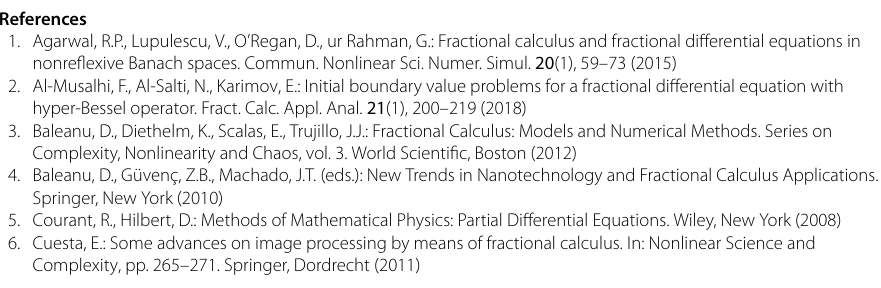
problem is not well posed (in the sense of Hadamard). Secondly, by the fractional Landwe- ber and Tikhonov methods, we showed the results of the convergence rates for the reg- ularized solution to the exact solution by using a priori and a posteriori regularization parameter choice